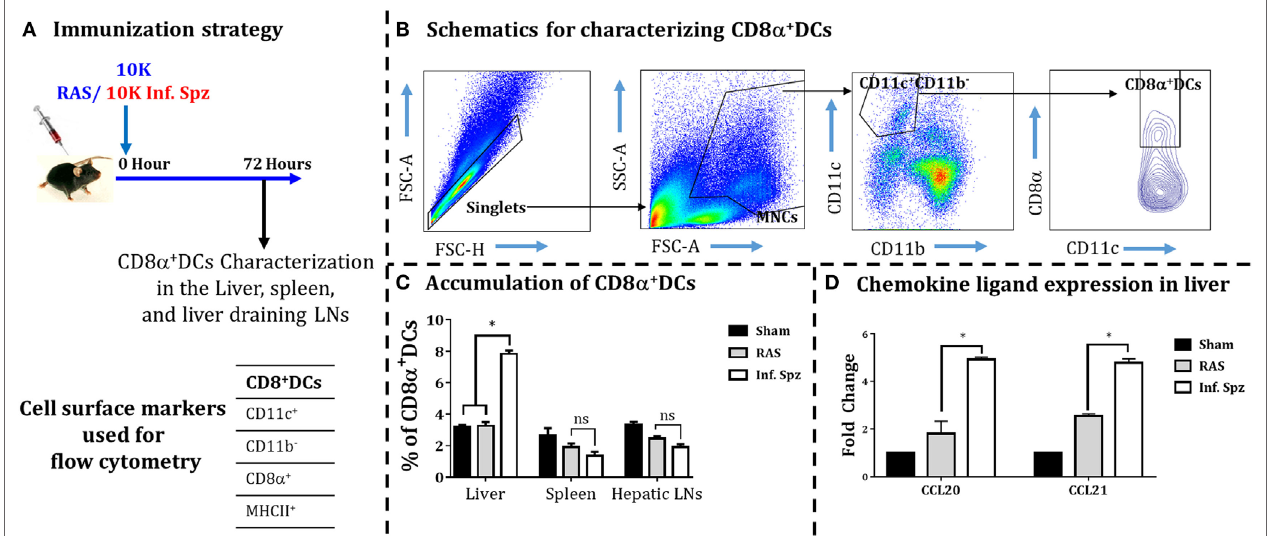
FigUre 3 | Accumulation of dendritic cells (DCs) in different organs [liver, spleen, and liver-draining lymph nodes (LNs)] in response to radiation-attenuated sporozoites (RAS) or infectious sporozoites (Inf. Spz) inoculation. (a) C57BL/6 mice were inoculated with 10K RAS or Inf. Spz and mice sacrificed 72 h postinoculation. (B) Gating strategy for characterizing DCs, used to define CD11c + CD11b − CD8 α + DCs within the mononuclear cells (MNCs). Murine DC subsets were differentiated via expression of CD8 α on CD11c + CD11b − cells from liver, spleen, and liver-draining LN. The FACS plot is a representation from the liver. (c) Accumulation of CD8 α + DCs in liver and lymphoid organs. The graphs present the percent cells out of total MNCs. Each bar shown in graph is mean of four mice per group. * p < 0.05, relative to corresponding RAS inoculated group. (D) Measurement of the expression of chemokine ligands (CCL20 and CCL21) in RAS or Inf. Spz inoculated mice through qPCR. The expression of β -actin gene in individual sample was used as an internal control for each mouse. Data are expressed as the fold induction of the gene of interest in the different activation conditions compared with sham control group. Data are the mean ± SEM. The data were analyzed with non-parametric Mann–Whitney U -test. p < 0.05 is considered as a significant. N = 4 mice per group. Data shown represent one of two independent